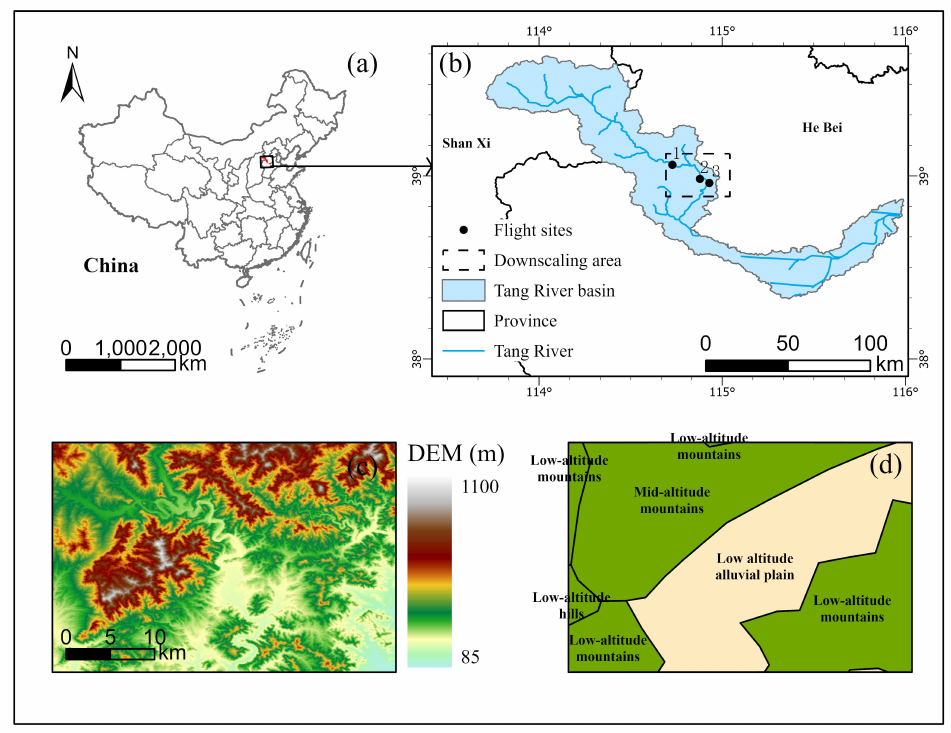
Figure 1. ( a ) Location map of Tang River basin in China; ( b ) Location map of the downscaling area in the Tang river basin; ( c ) The elevation map of the downscaling area; ( d ) Geomorphological map of the downscaling